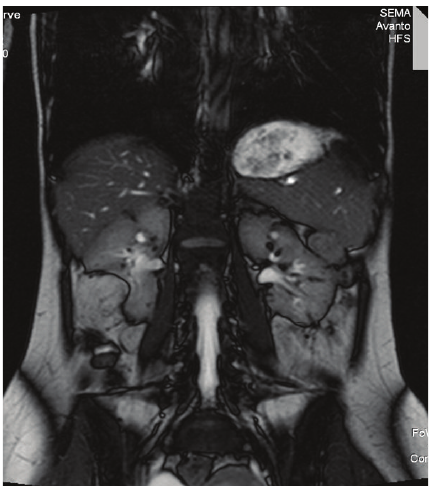
with fatty tissue on T1 weighted images is seen at lower pole of left